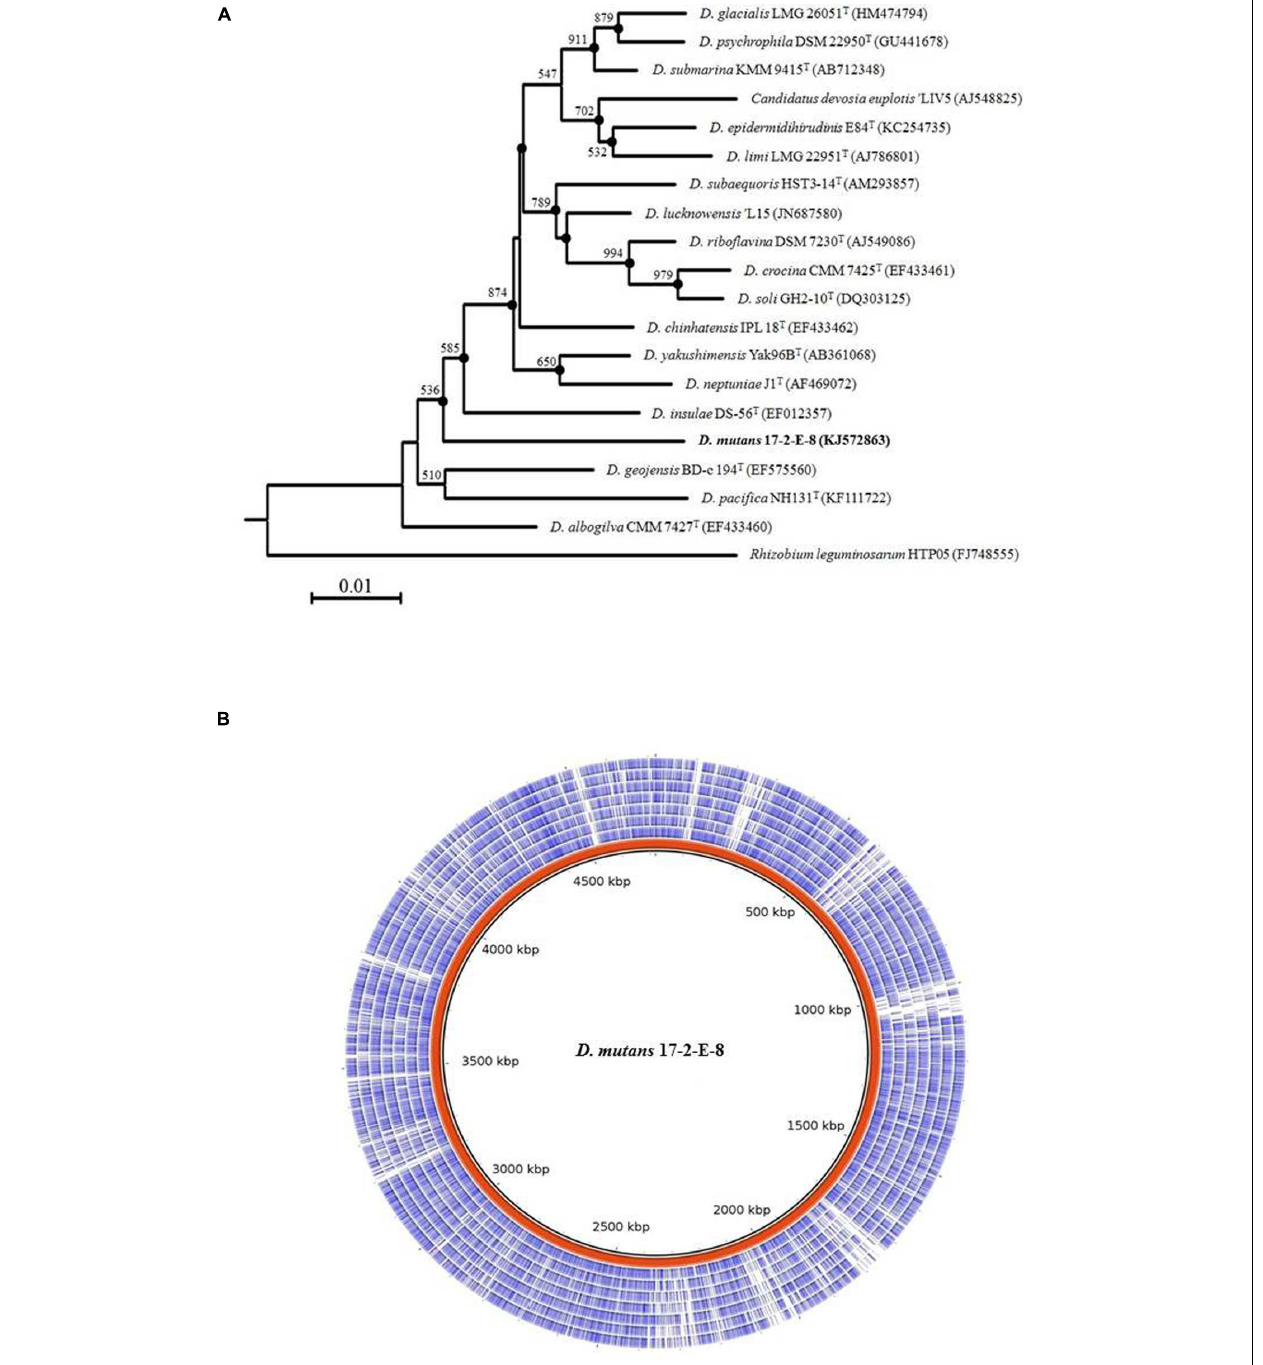
FIGURE 6 | Isolate 17-2-E-8 represents a new Devosia species. (A) 16S rRNA gene phylogenetic tree reconstruction. The genus Devosia currently has sixteen characterized species. There is also one species that is not validated yet. 16S rRNA gene phylogenetic analysis shows how isolate 17-2-E-8 relates to the other species. The tree was generated using neighbor-joining method as described earlier with 1000 bootstraps. Filled circles indicate that the corresponding branches were also recovered in the maximum-parsimony method. Bootstrap resampling values ( > 50%) are shown with a scale at the bottom reflecting nucleotide substitutions. Bar, 0.01 substitutions per nucleotide position. (B) Pair-wise comparisons of multiple genomes of Devosia type-strains assembled using the de novo approach. The entire genome of Devosia mutans 17-2-E-8 (in red) was aligned with D. geojensis (DSM19414), D. psychrophila (DSM22950), D. chinhatensis (DSM24953), D. soli (DSM17780), D. limi (DSM17137), D. epidermidihirudinis (DSM25750), and D. riboflavin a (IFO13584) genomes (inner to outer circles, respectively). Nucleotide sequence comparisons were conducted using BRIG. The comparison clearly shows the uniqueness of Devosia 17-2-E-8 at the genome level in relation to the closest validated Devosia